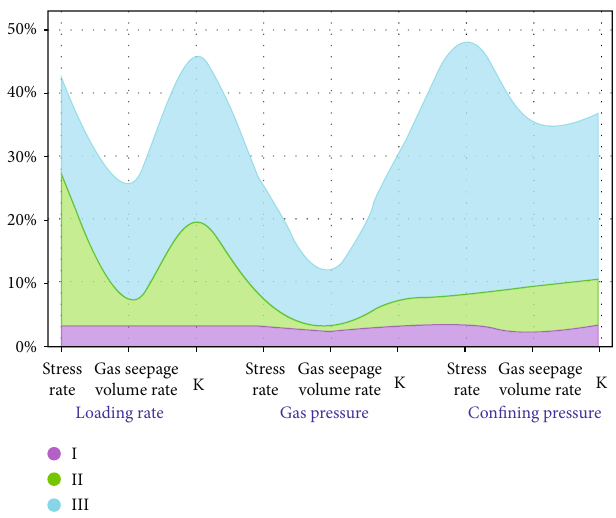
Figure 17: Proportional accumulation diagram of each index at the crack growth